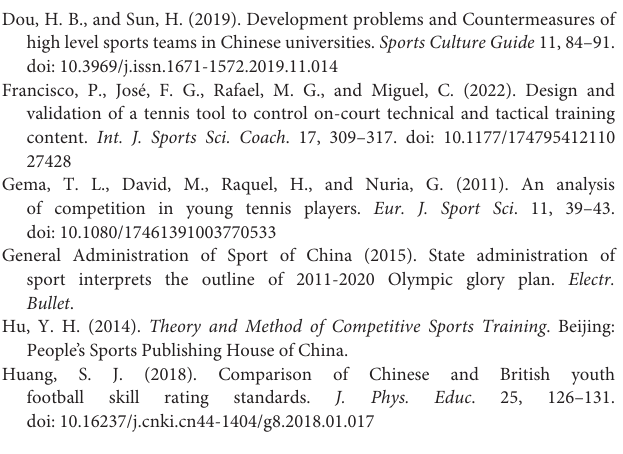
weight table of training quality evaluation indexes for high-level tennis